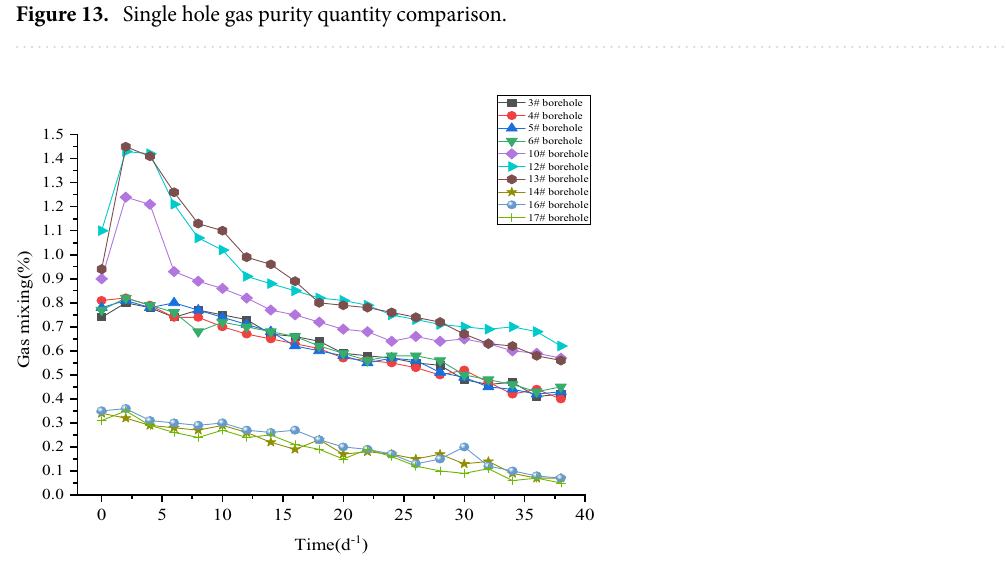
Figure 13. Single hole gas purity quantity comparison.